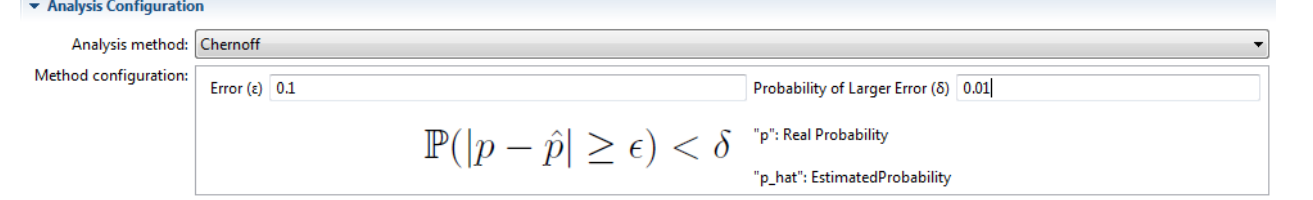
Figure 7. DESYRE ’s SMC Analysis Configuration Editor.